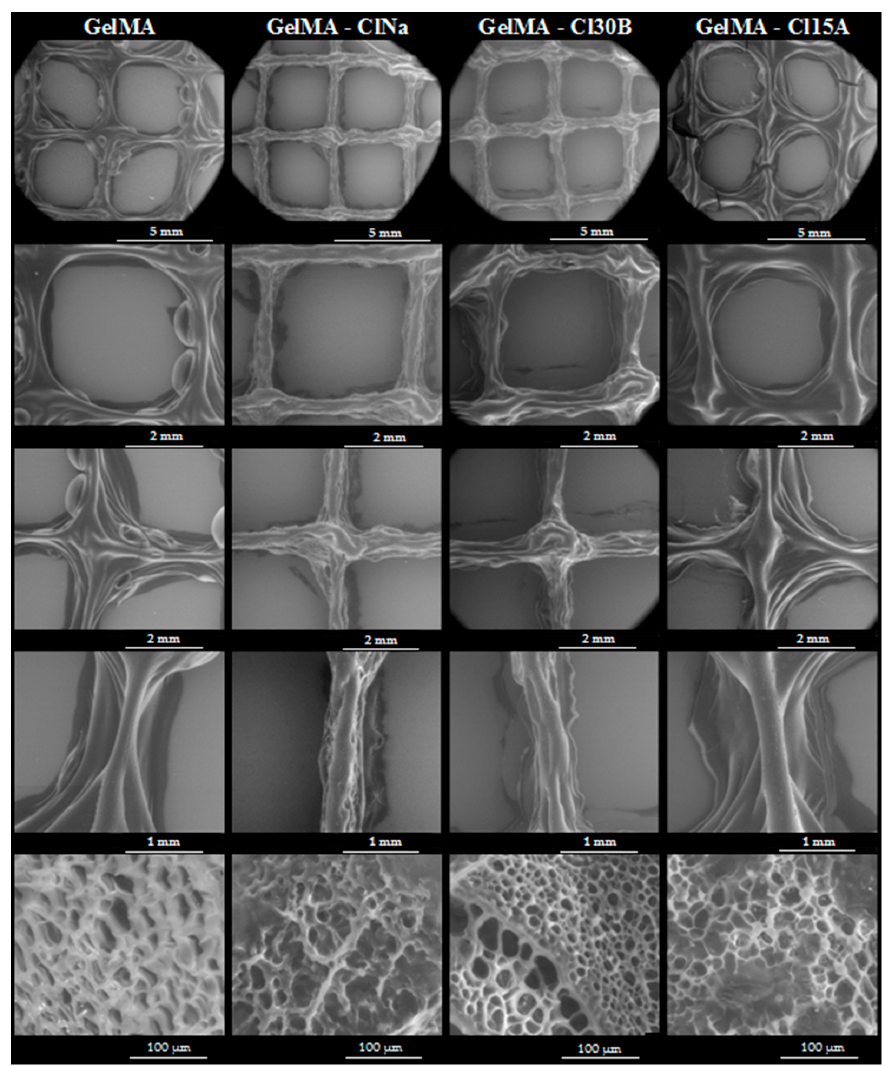
Figure 12. SEM images showing the microstructure aspect of GelMA, GelMA-ClNa, GelMA-30B and GelMA-15A scaffolds (magnitude ×25, ×50, ×50, ×100, ×1000). The porosity of the material was also confirmed by micro-CT, which showed that the porosity of nanocomposite samples is different depending on the type of clay used in syn- thesis (Figure 13). Thus, the GelMA-based nanocomposite with ClNa presents the largest